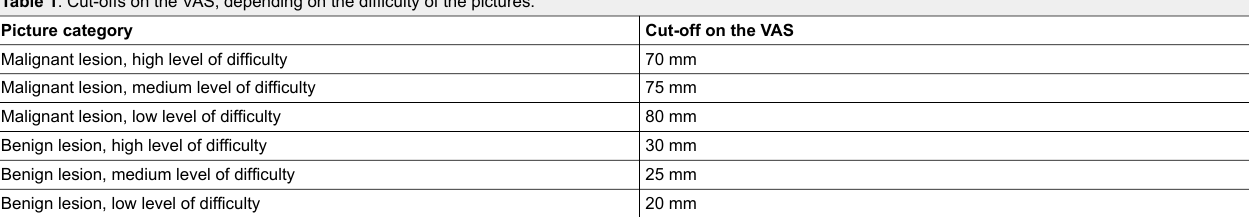
Table 1 : Cut-offs on the VAS, depending on the difficulty of the pictures. Picture category Cut-off on the VAS Malignant lesion, high level of difficulty 70 mm Malignant lesion, medium level of difficulty 75 mm Malignant lesion, low level of difficulty 80 mm Benign lesion, high level of difficulty 30 mm Benign lesion, medium level of difficulty Benign lesion, low level of